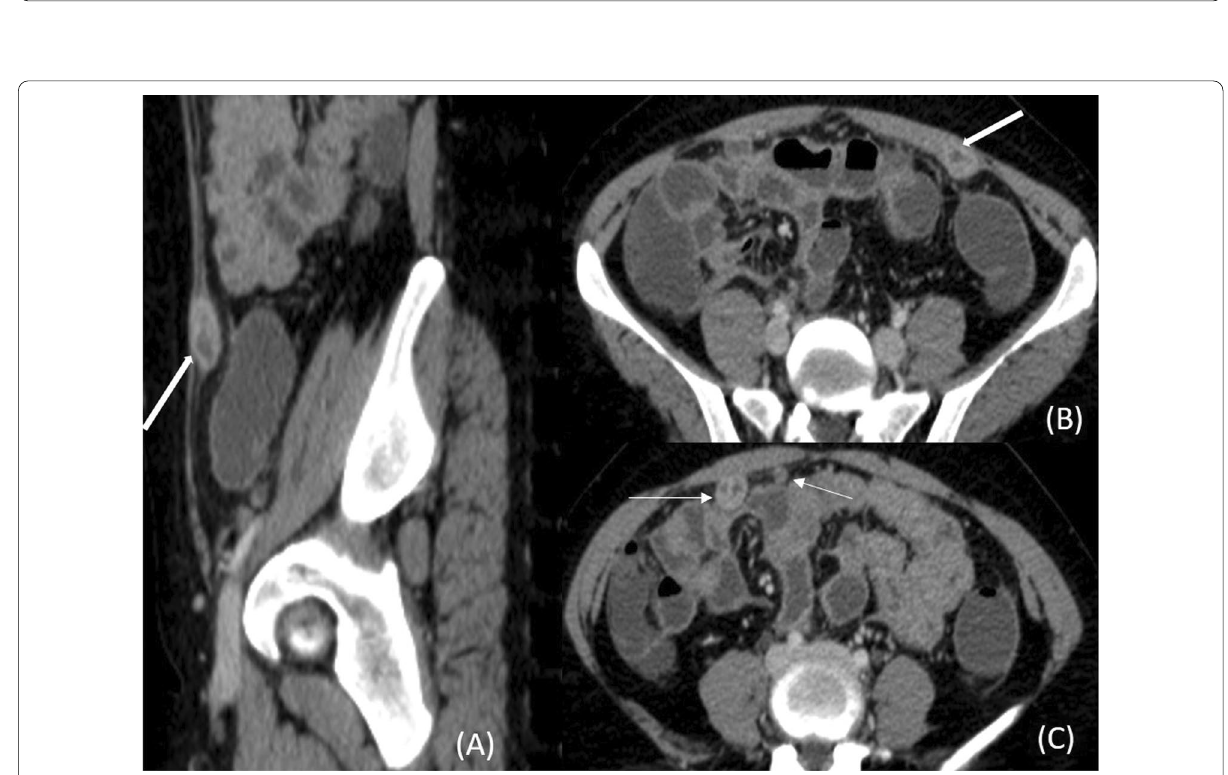
Fig. 17 Abdominal tuberculosis with abdominal wall deposits. CT images of a 28-year-old female show a well-defined peripherally enhancing nodular lesion in left rectus abdominis muscle (solid white arrow in A and B ) with similar morphology lesions in omentum (thin white arrows in C